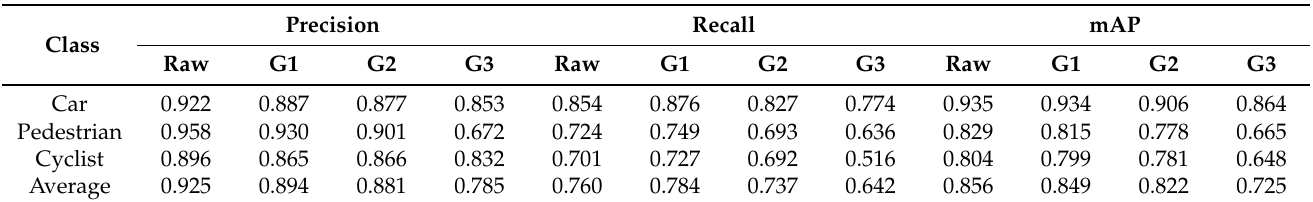
Table 8. Evaluation metrics for KITTI point cloud data compressed at different degrees, from raw to high, converted with the Delaunay Triangulation and evaluated using the best YOLOv5l model, trained over the course of 200 epochs with a batch size of 10.